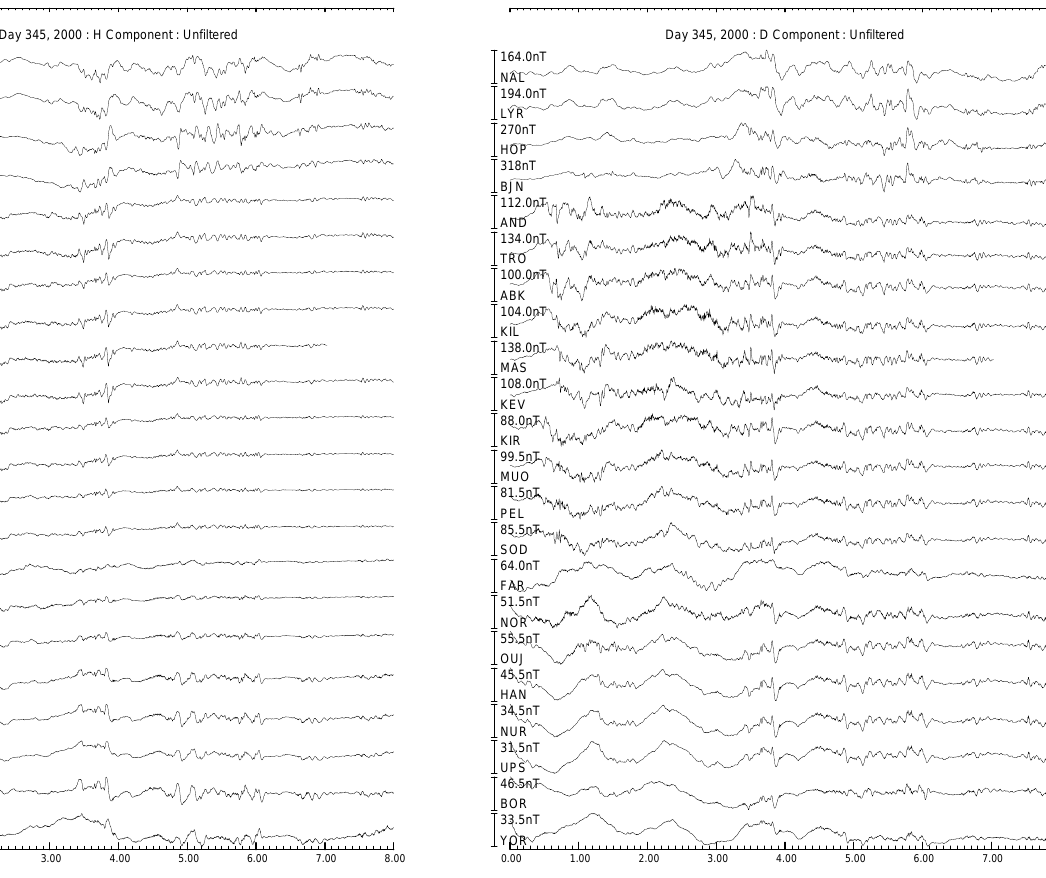
Fig. 12. Cluster four spacecraft measurements of | B | in the intervals